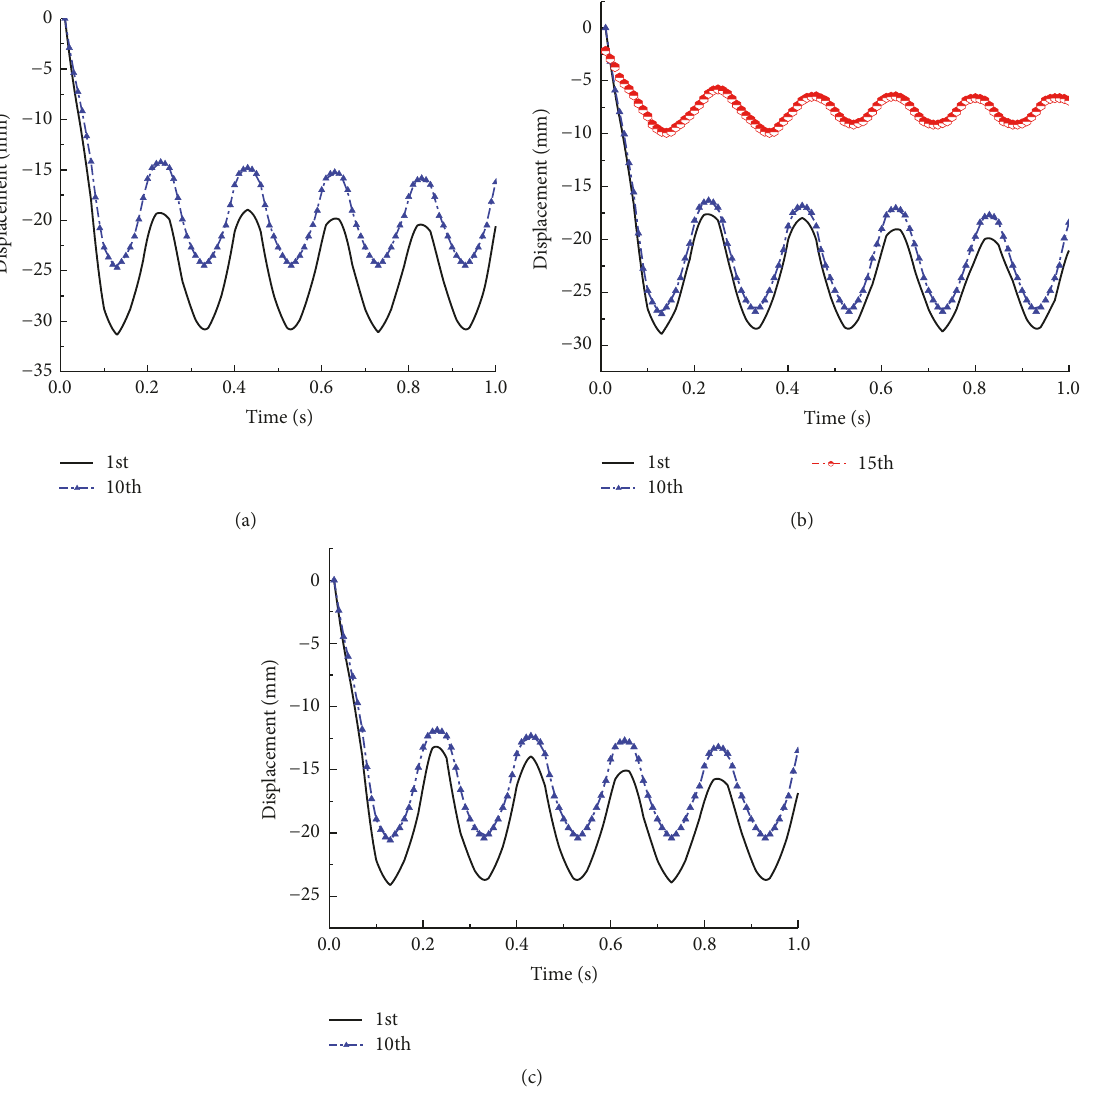
Figure11:Removal ofshort-sidemiddlecolumn in building: (a)10-storymodel; (b)15-storymodel; (c)10-storymodel ofthe8-degreeseismic design; (a)–(c) vertical displacement of the joint at the top of the removed column on the 𝑥